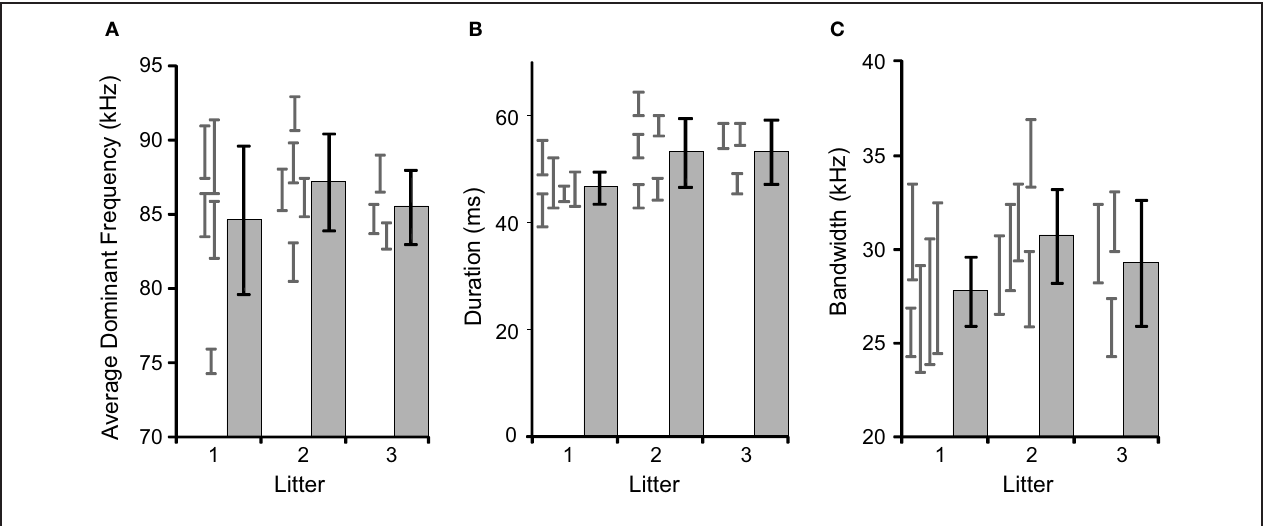
FIGURE 1 | Comparisons of inter- and intra-litter differences in basic acoustic features. The gray histograms with black error bars represent the mean and 95% confidence intervals for litters, with the gray error bars